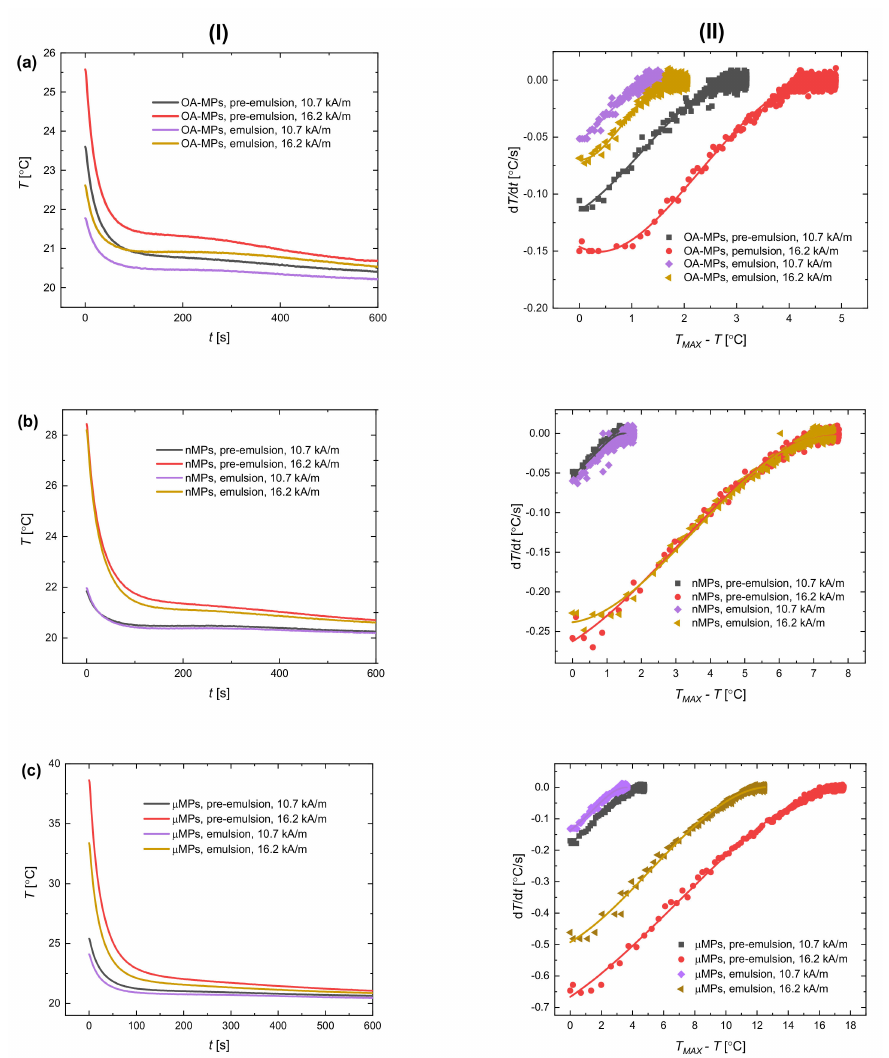
Figure 5. ( I ) The temperature versus time during cooling down after heating and ( II ) the temperature change rate versus temperature di ff erence after magnetic heating for pre- and emulsions stabilized with ( a ) OA-MPs, ( b ) nMPs, and ( c ) µ MPs particles for measurements under the AC magnetic field of an amplitude of 10.7 and 16.2 kA / m. The experimental points representing d T / d t (recorded every second) were fitted to polynomial from Equation (2) whose trending lines were added. The mass concentration of silicone oil in relation to castor oil and the concentration of magnetite were the same for each of samples (10% and 2.3%, respectively), and the operating time of the AC magnetic field was 30 s. The results had uncertainty values of 1–5% that were not presented in the graph for better